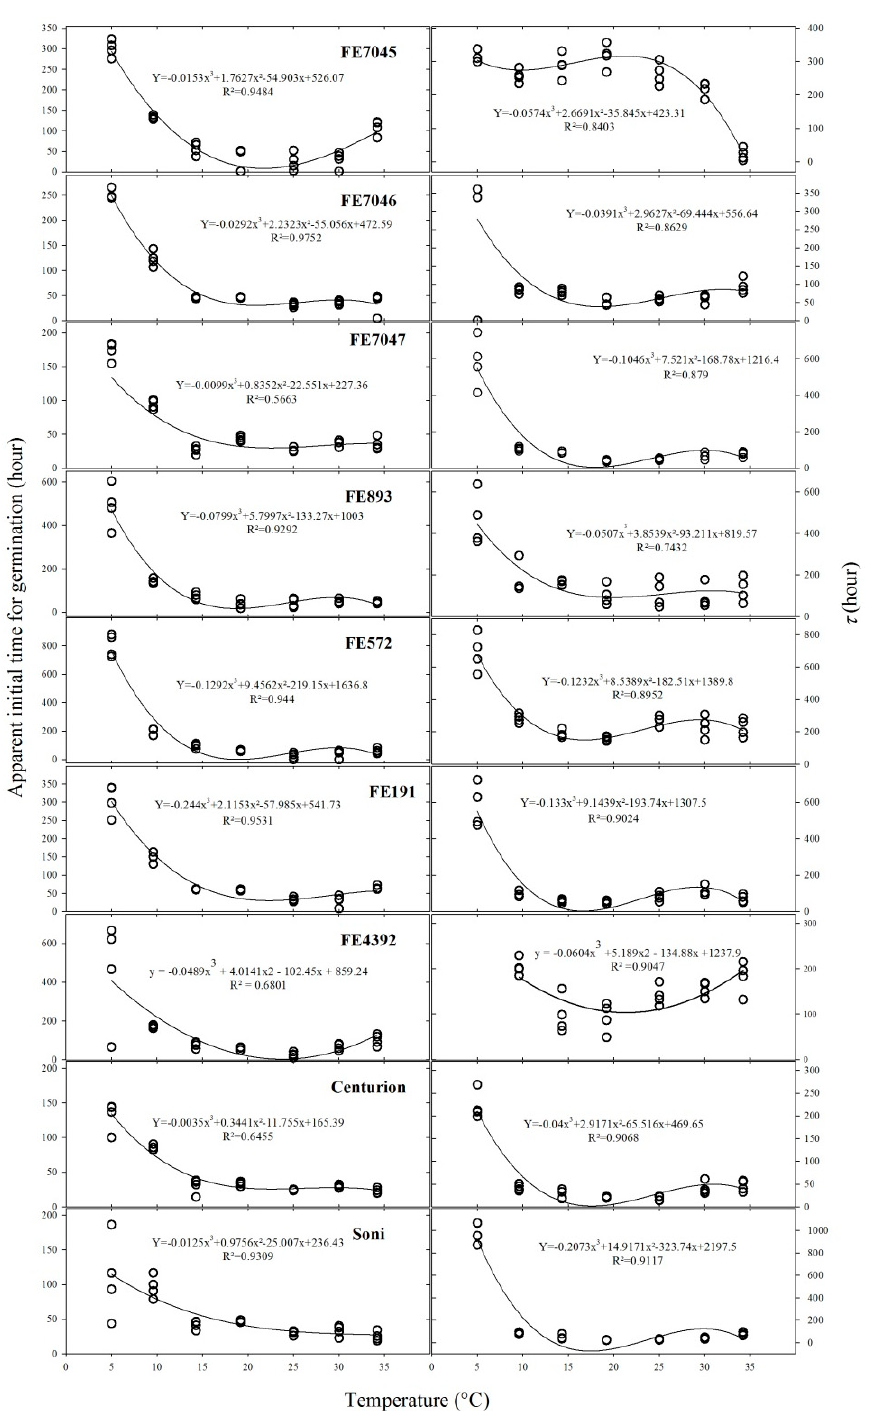
Figure 3. Apparent initial time ( tc ) ( Left ) and time when 50% of the seeds germinate ( τ ) estimated for nine accessions of F. arundinacea in response to a constant temperature ( Right ).